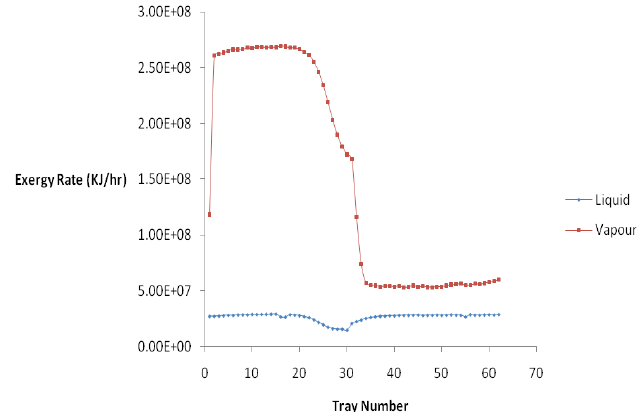
Figure 28. Profile of exergy rate versus tray number for Debutanizer of base 800KPa